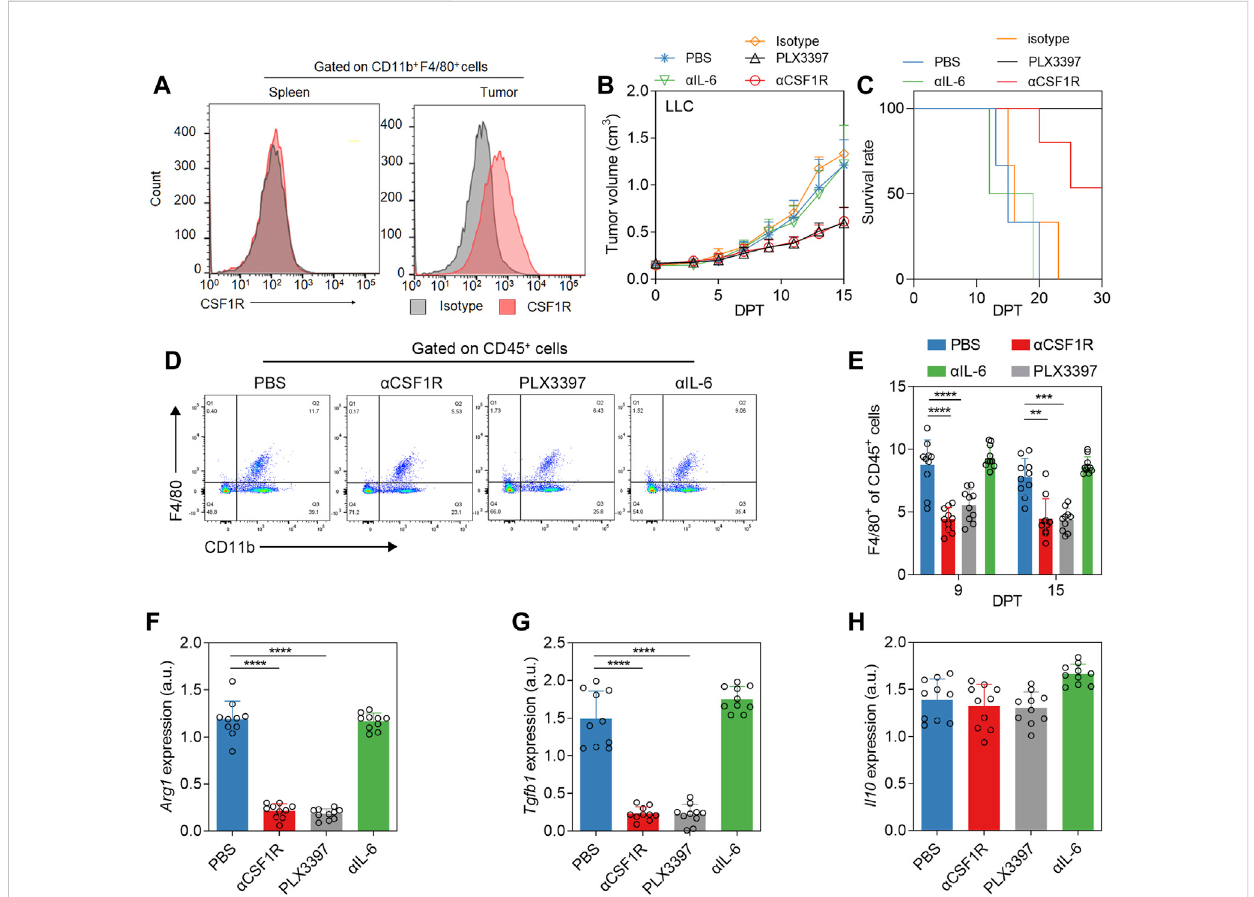
FIGURE 1 PhenotypicchangesofTAMafter α CSF1RorPLX3397treatment. (A) Representative fl owcytometryhistogramofCSF1Rlevelsinmacrophagesinthe spleen or tumor of LLC subcutaneous tumor model, results showed that the CSF1R level in TAM was upregulated. (B) When the tumor volume reached 0.1 – 0.2 cm 3 on the 7 – 10 days after subcutaneous tumor inoculation, the treatment experiment was performed according to the description in the method. PLX3397 was administered orally and α CSF1R was administered intravenously. Changes in tumor volume and (C) survival of mice were observed, error bar = ±S.D., n = 10. (D) Representative fl ow cytometry dot plot of TAM depletion on nine DPT; (E) statistical results of TAM depletion on nine DPT and 15 DPT. On 15 DPT, macrophages in the tumor were separated and the transcription levels of (F) Arg 1, (G) Tgfb1 and (H) Il10 were analyzed by qPCR, with error bar =